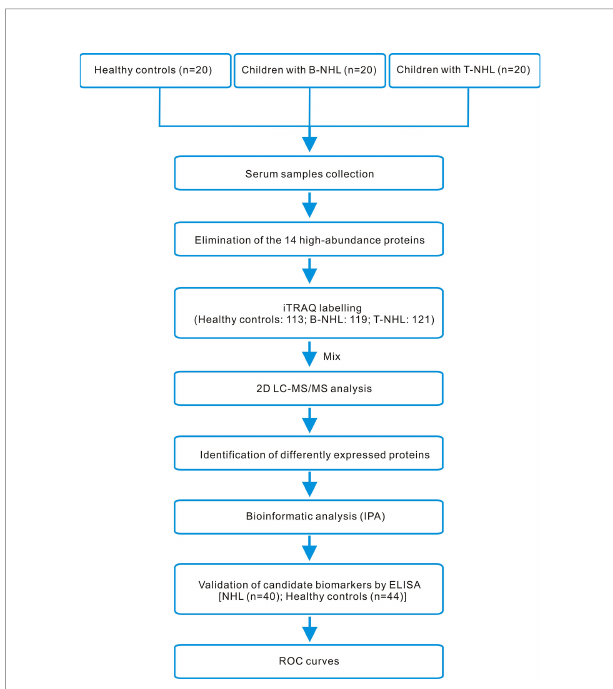
FIGURE 1 | iTRAQ-based proteomics work fl ow of this study. Serum samples from healthy controls and children with B-NHL and T-NHL were pooled. After elimination of the 14 high-abundance proteins by applying the Human 14 Multiple Af fi nity Removal System (MARS), tryptic digestion and iTRAQ labeling, the peptide mixture was analyzed by 2D LC – MS/MS. The differentially expressed proteins were analyzed by the bioinformatics software IPA. The candidate biomarkers S100A8 and LRG1 were selected for further validation using ELISA. The ef fi cacy of the candidate biomarkers was then evaluated using ROC